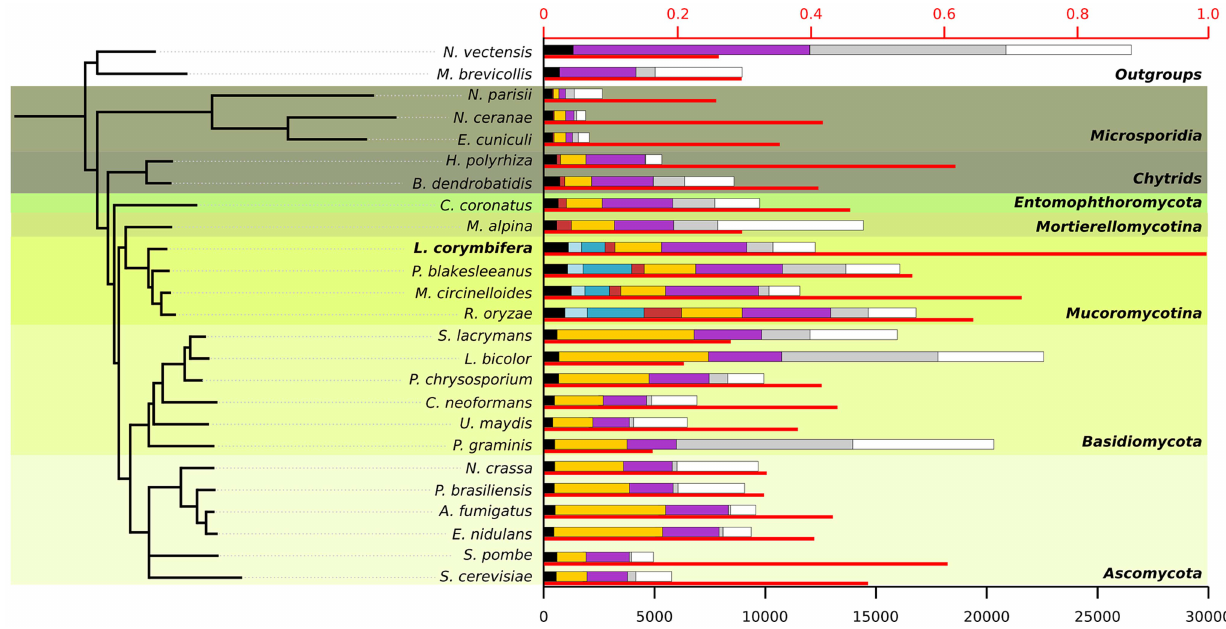
Figure 1. Species tree including the 25 species used during phylome reconstruction. For each species the thin red bar represents the proportion of proteins that have a homolog in L. corymbifera (upper axis). The coloured bars represent the number of proteins found in different ranges of species (lower axis): black: wide-spread proteins found in at least 23 of the 25 species, light blue: proteins found exclusively in all four Mucorales species, darker blue: proteins found only in Mucorales species, red: proteins found in early diverging fungi, yellow: proteins found in fungi, purple: proteins found in fungi and at least one of the outgroups, grey: species-specific proteins without orthologs in other species but with paralogs within the genome, white: proteins with no homologs. All nodes in the tree have a bootstrap support of 100.